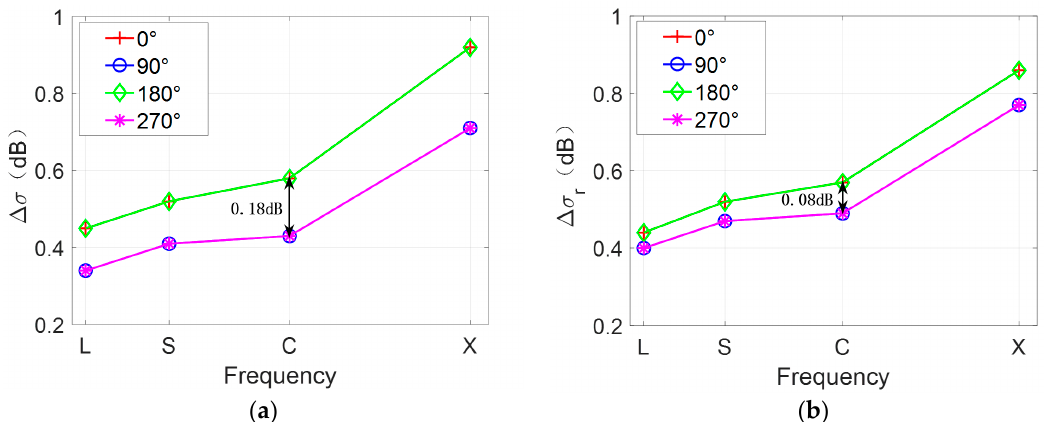
Figure 13. ( a ) Normalized radar cross section (NRCS) contrast of eddy spirals ∆ σ and ( b ) NRCS contrast of SAR image ∆ σ r under different look directions and radar frequencies. Fifty simulations are averaged to reduce speckle bias.